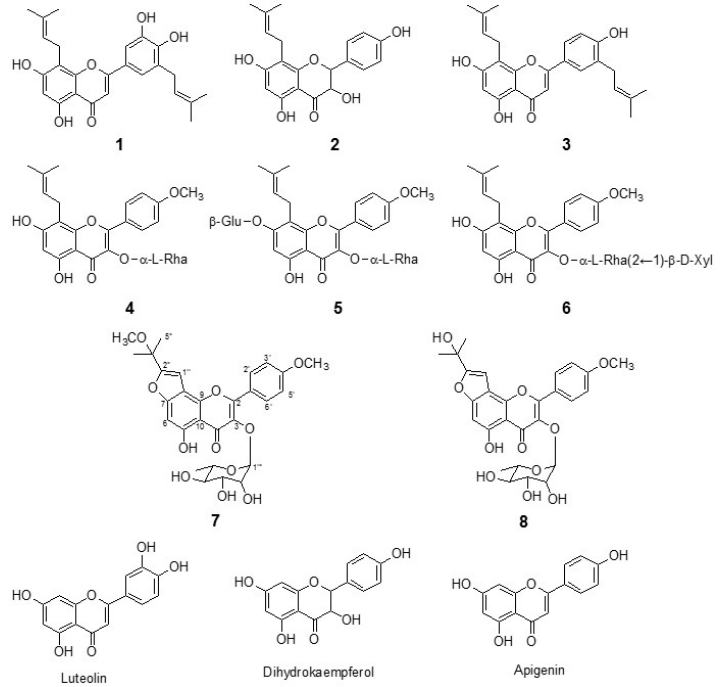
Figure 1. Chemical structures of flavonoids ( 1 – 8 ) from Epimedium koreanum